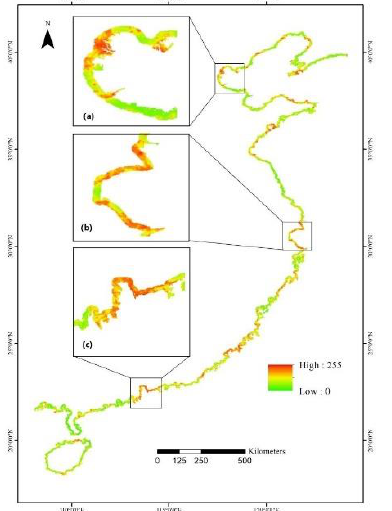
Figure 2. Coastal luminous radiation distribution (2019). (a) Beijing-Tianjin-Hebei region; (b) Yangtze River Delta; (c) Pearl River